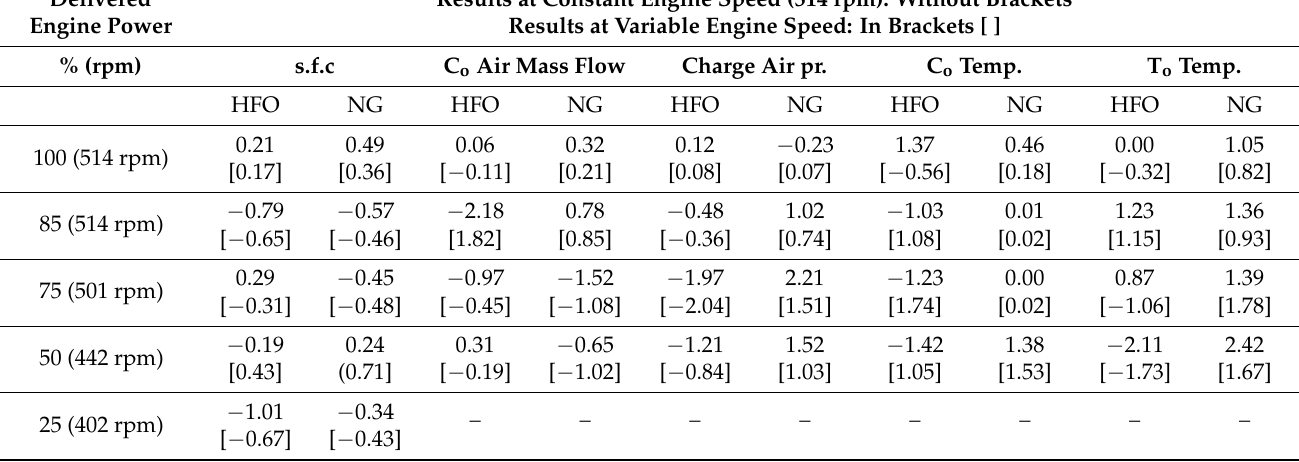
Table 2. Errors (%) comparison between reference data and simulation. Results at Constant Engine Speed (514 rpm): Without Brackets Results at Variable Engine Speed: In Brackets [